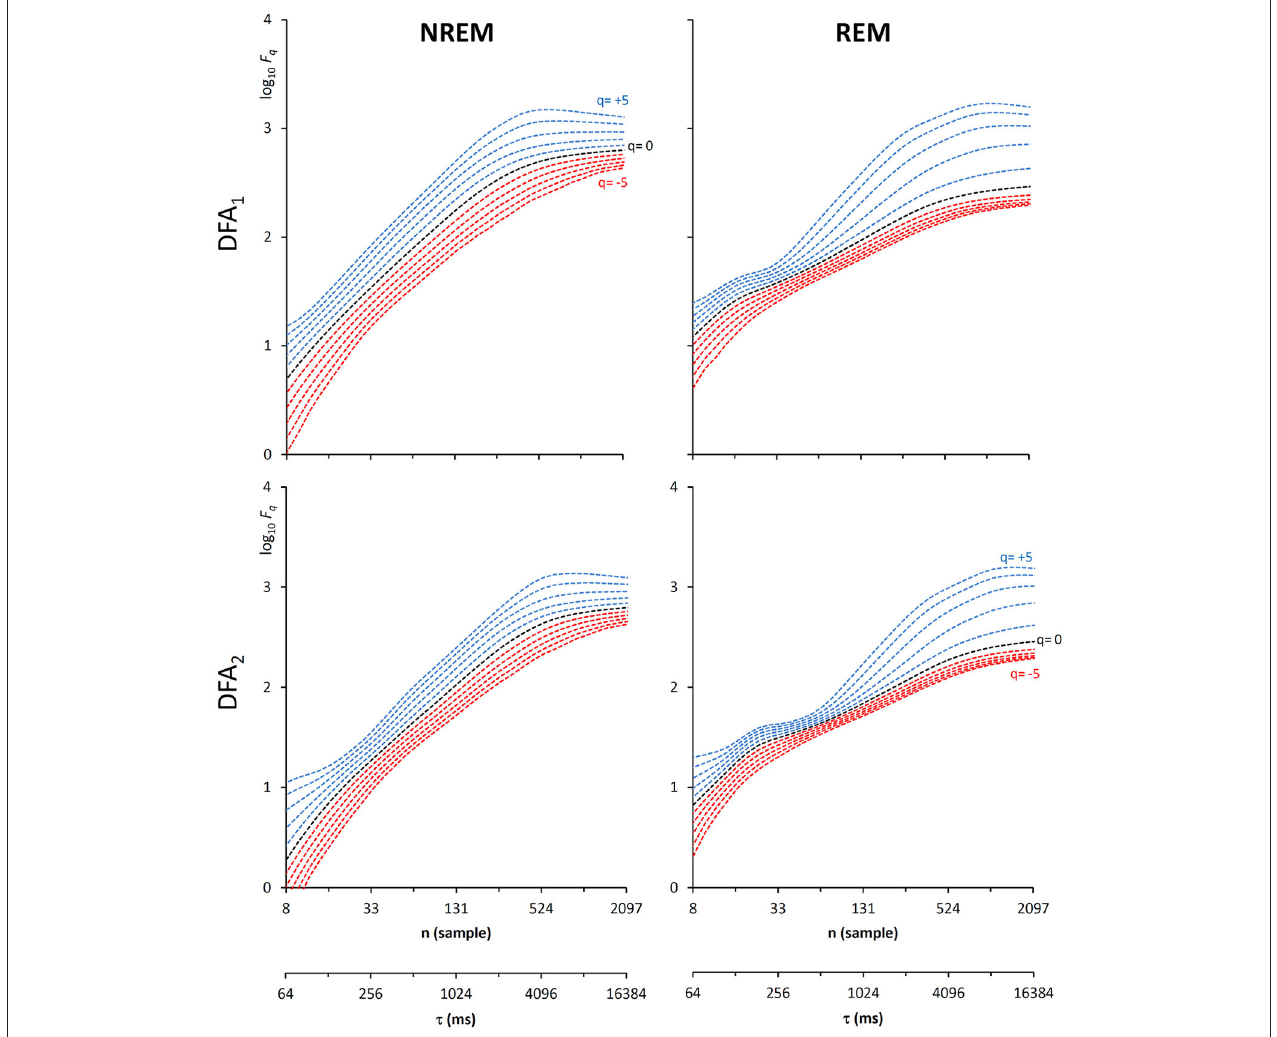
FIGURE 11 | Fluctuation functions of EEG during NREM and REM sleep with maximally overlapped blocks. Time series are 1600-s segments of an EEG C4 lead sampled at 128Hz during sleep in a healthy volunteer. The first horizontal axis is the box size, n , in number of samples, the second horizontal axis is the temporal scale, τ , in milliseconds, obtained multiplying n by the sampling period. Thresholds Th 1 and Th 2 as in Equations (19) and EPS = 10 − 4 .